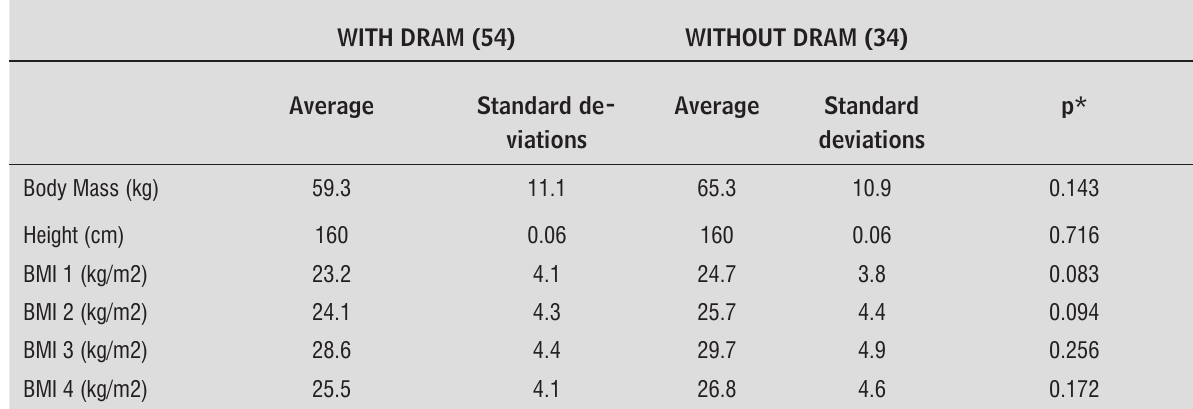
Table 3 - Comparison of the average body weight before, during and after pregnancy, according to group, Guarapuava, PR, 2012. Student's t test, significance level p < 0.05